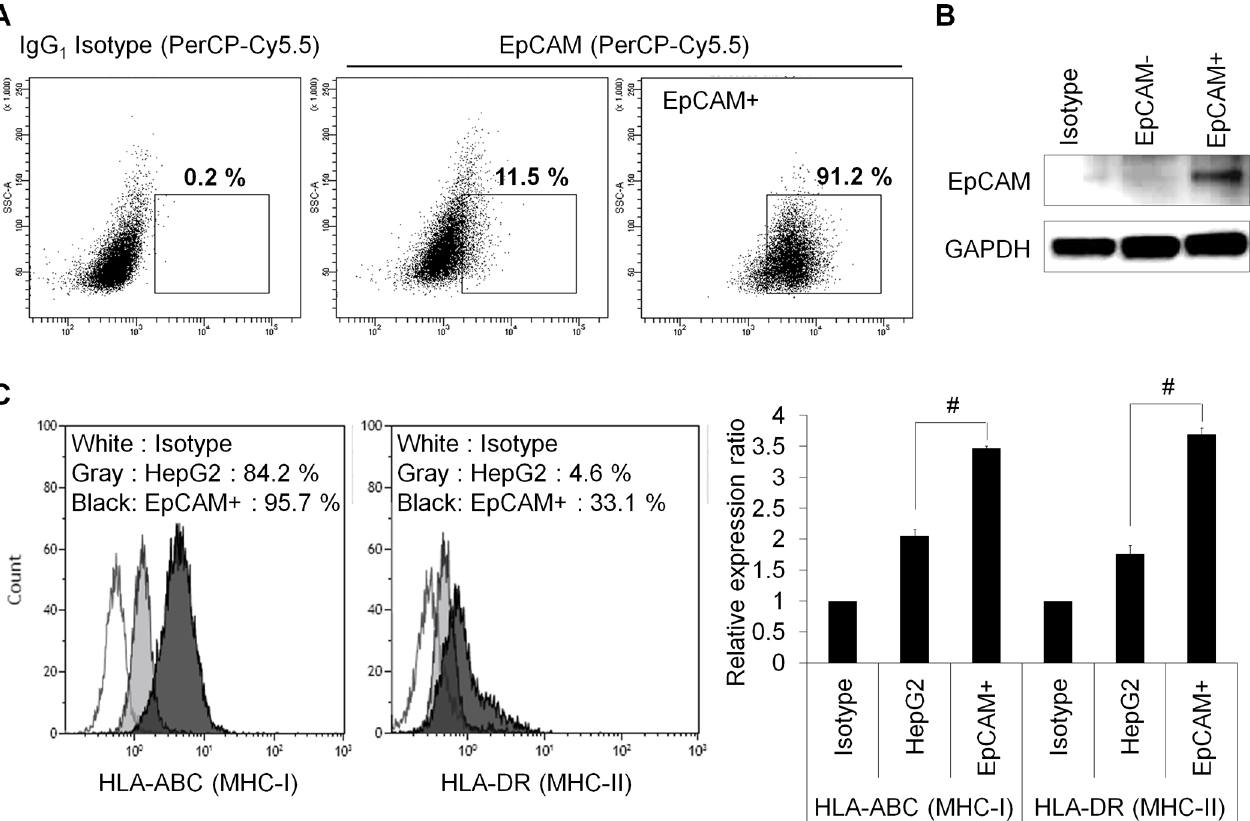
Fig 2. The immunological phenotype of HepG2 cancer stem-like cells. (A) The top 10% most brightlystained EpCAM positive HepG2 cells were purifiedby flow cytometry. A representative analysisof EpCAM + HepG2 cell purity after sorting is shown. (B) The expressionof EpCAM in EpCAM negativeor positive HepG2 cells was evaluatedusing western blot analysis. (C) Flow cytometry analysisof HLA-ABC (MHC-I) and HLA-DR(MHC-II) expressionin EpCAM + HepG2 cells. HLA-ABC and HLA-DRexpressionin EpCAM + HepG2 cells is indicatedby the black areas. The data are expressed as the mean ± SD, and significantdifferences betweenthe treated groupswere detected using ANOVA followedby the Dunnett’s test. # p < 0.05comparedwith the HepG2.